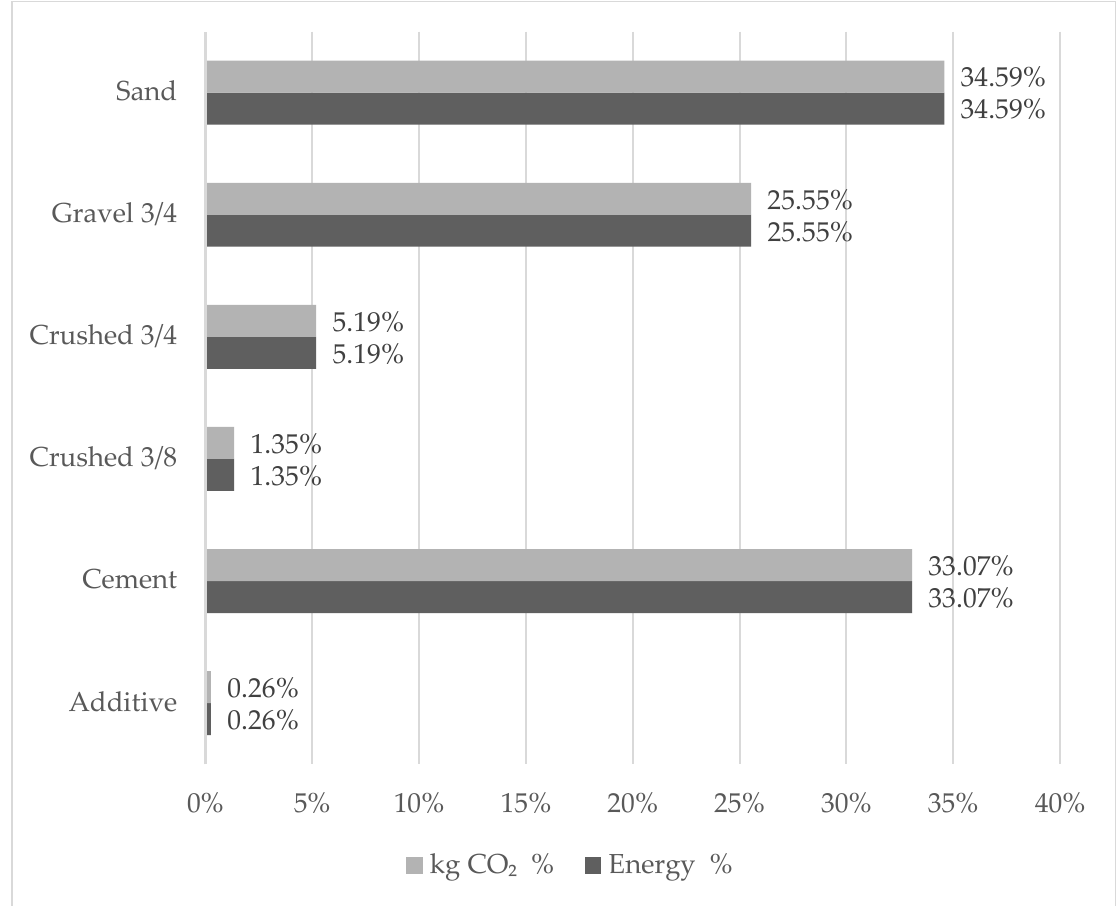
Figure 4. Embodied energy and CO 2 emissions from the transport of each raw material.